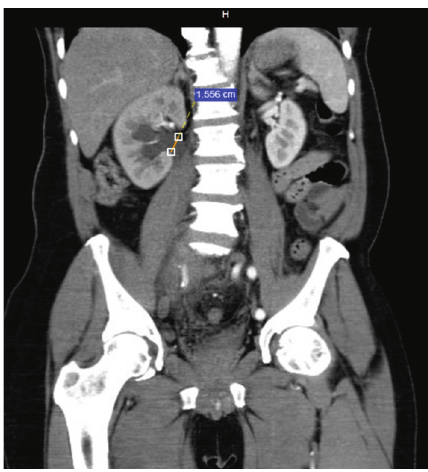
Figure 1: CT-IVU showing the right sided hydroureteronephrosis